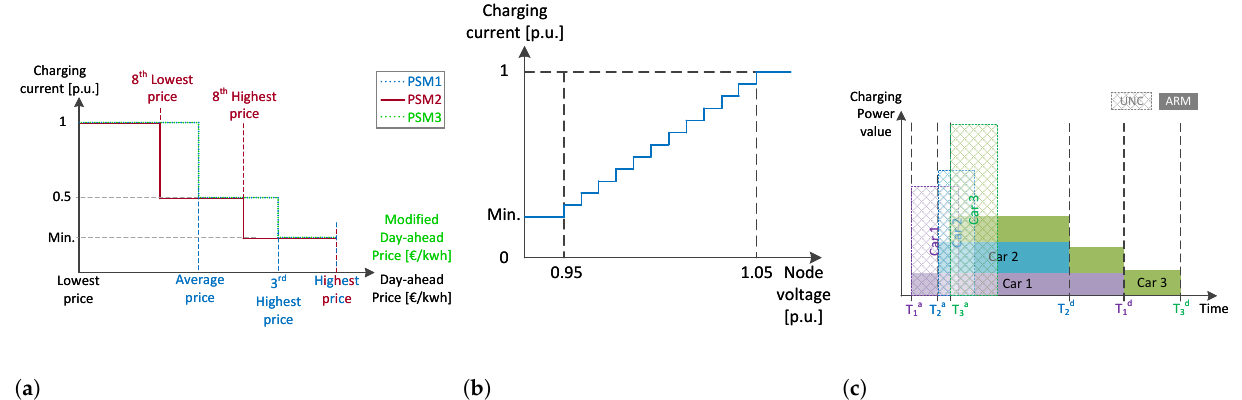
Figure 1. Illustration of three charging methods’ control mechanism: ( a ) PSM, ( b ) VDM, ( c )